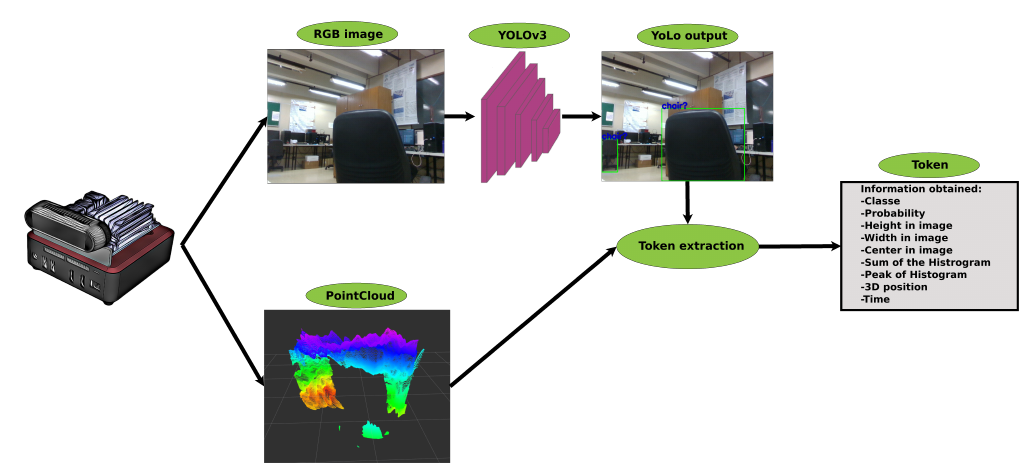
Figure 3. An overview of Lexical